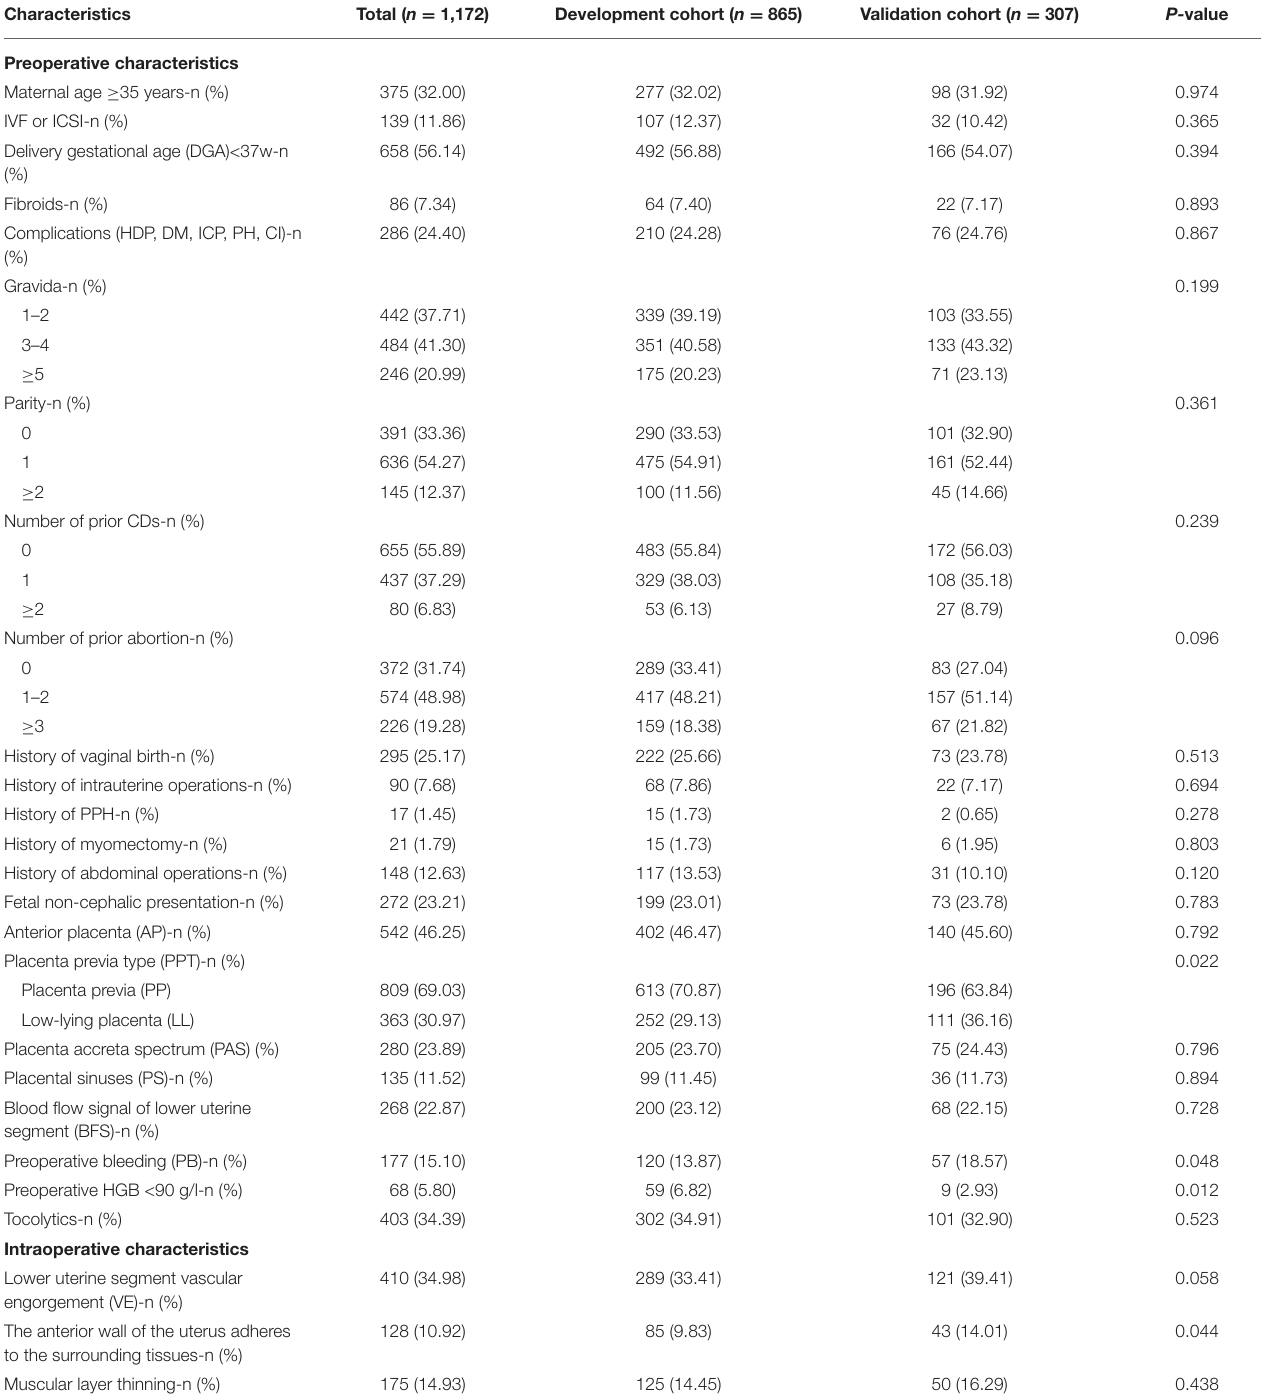
TABLE 1 | Baseline characteristics of patients in the development cohort and validation cohort.